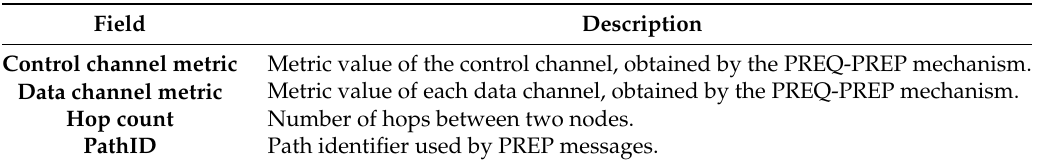
Table 2. New fields added to the HWMP routing